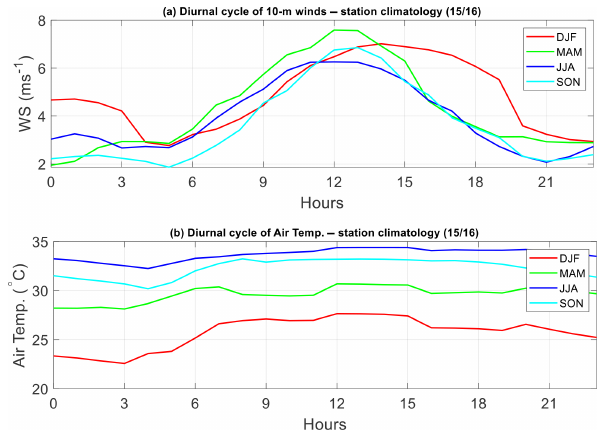
Figure 2. Seasonally averaged (2015/16) diurnal cycle of (a) 10m wind speed and (b) 2m air temperature, both measured at the KAUST station. Times are reported in